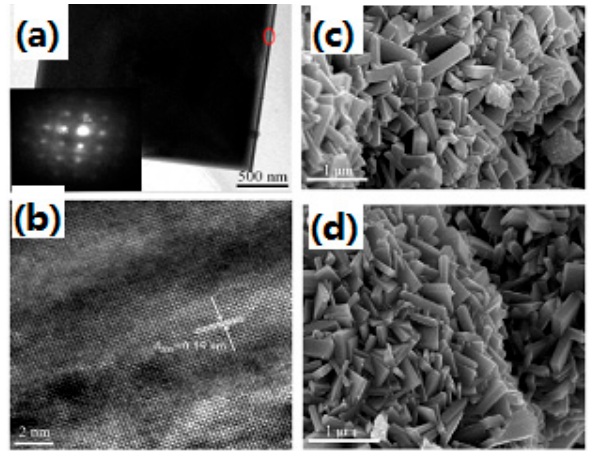
Figure 7. TEM image ( a ), HR-TEM image ( b ), and SEM image ( c , d ) of CFTS-1.0. The inset in Figure 6a is the selected area electron diffraction pattern. From Ref. [67]. Reprinted with permission from ACS.